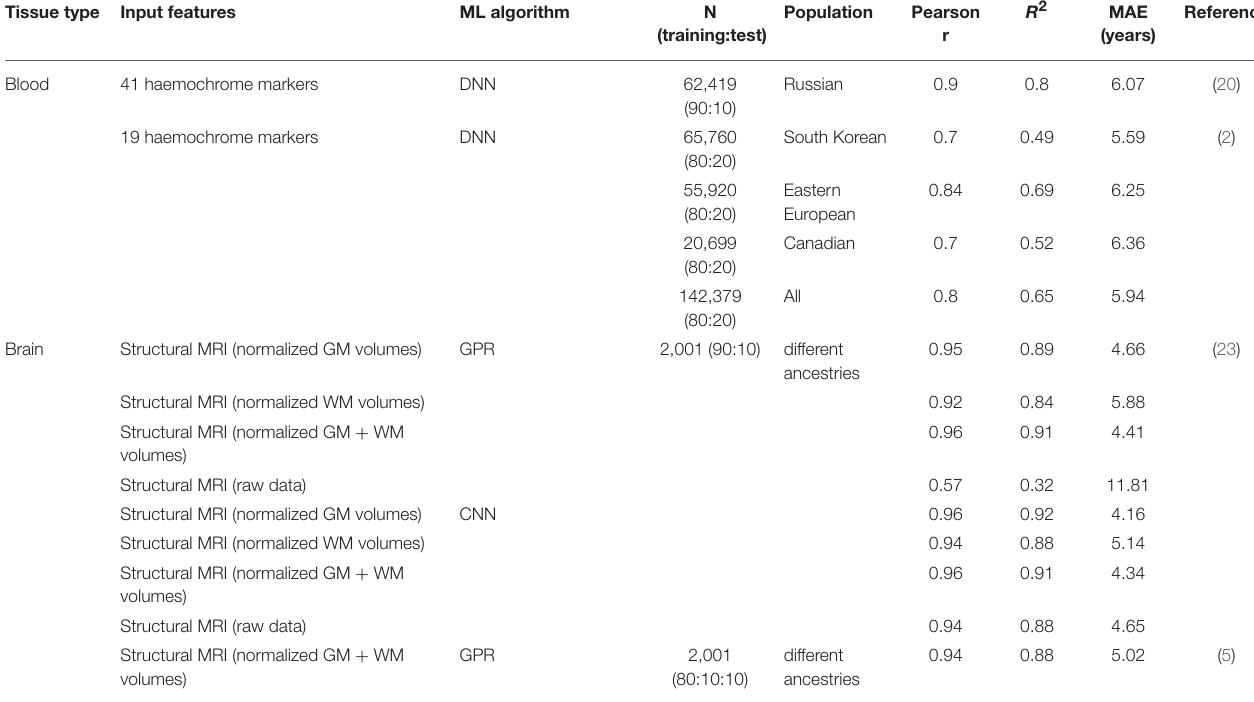
TABLE 1 | Main accuracy metrics of the biological age estimates described here. Tissue type Input